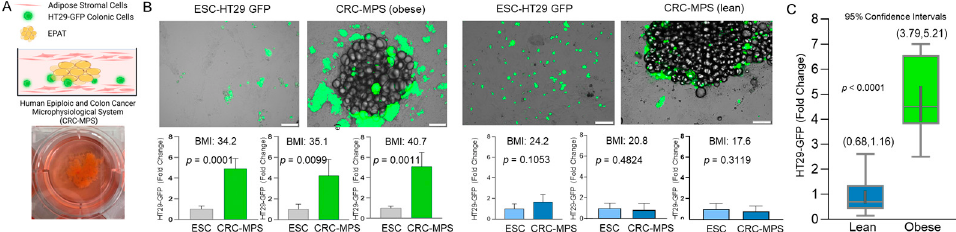
Figure 1. ( A ) Cross-sectional model of Epiploic (EPAT) Colorectal Cancer Microphysiological System (CRC-MPS). ( B ) Representative images of CRC-MPS with HT29-GFP cells and EPAT obtained from obese (BMI 34.2) or lean (BMI 24.2) individuals vs. HT29-GFP grown with EPAT-derived stromal cells (ESC) only (48 h). Graphs represent the intensity of GFP pixels from CRC-MPS images, three independent wells for each EPAT, obtained from three obese or three lean individuals relative to ESC (Scale bar = 100 µm, BMI = Body Mass Index). ( C ) All individual values from CRC-MPS were normalized to matched ESC-only GFP signal, then normalized to lean average. Box and whisker plot represents the median, 25% and 75% quartiles, and highest and lowest values of each group. Thick dark grey bar within the box and whisker plot reports confidence interval (CI, 95%) with range in brackets above each